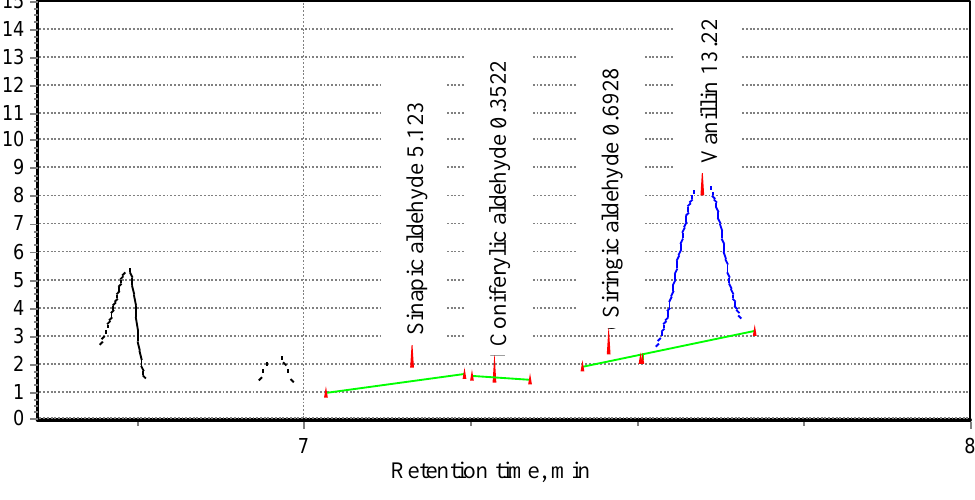
Fig. 4. Electrophoregram of experimental mixture of extracts – imitation of distilled drink. Table 3. Content of characteristic aromatic aldehydes in the aqueous-alcoholic extracts of vegetable raw materials and the experimental blend (an imitation of distilled